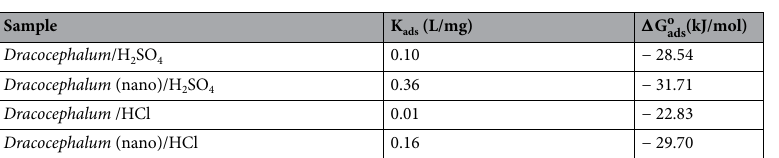
Table 5. Thermodynamic characteristics of adsorption obtained by PP measurements for st-37 in acidic media in the presence of varying concentration of extract.